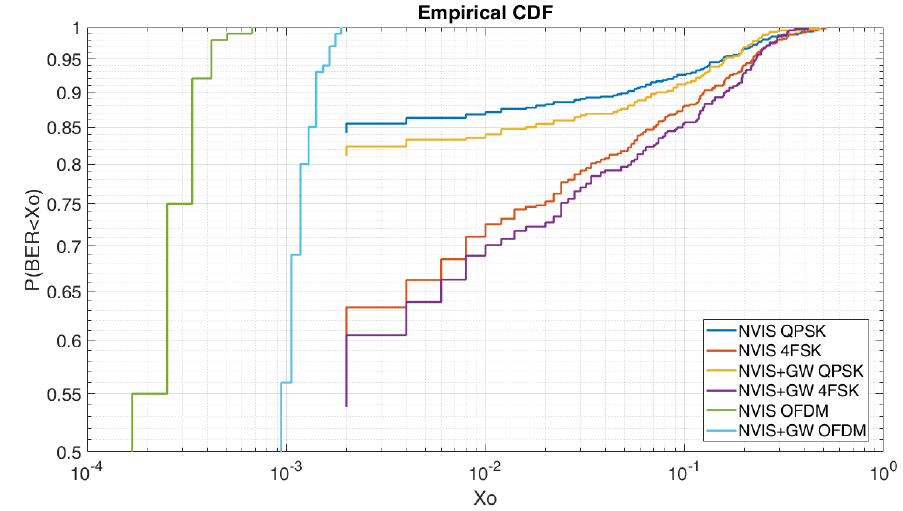
Figure 19. OFDM configurations CDF simulation.